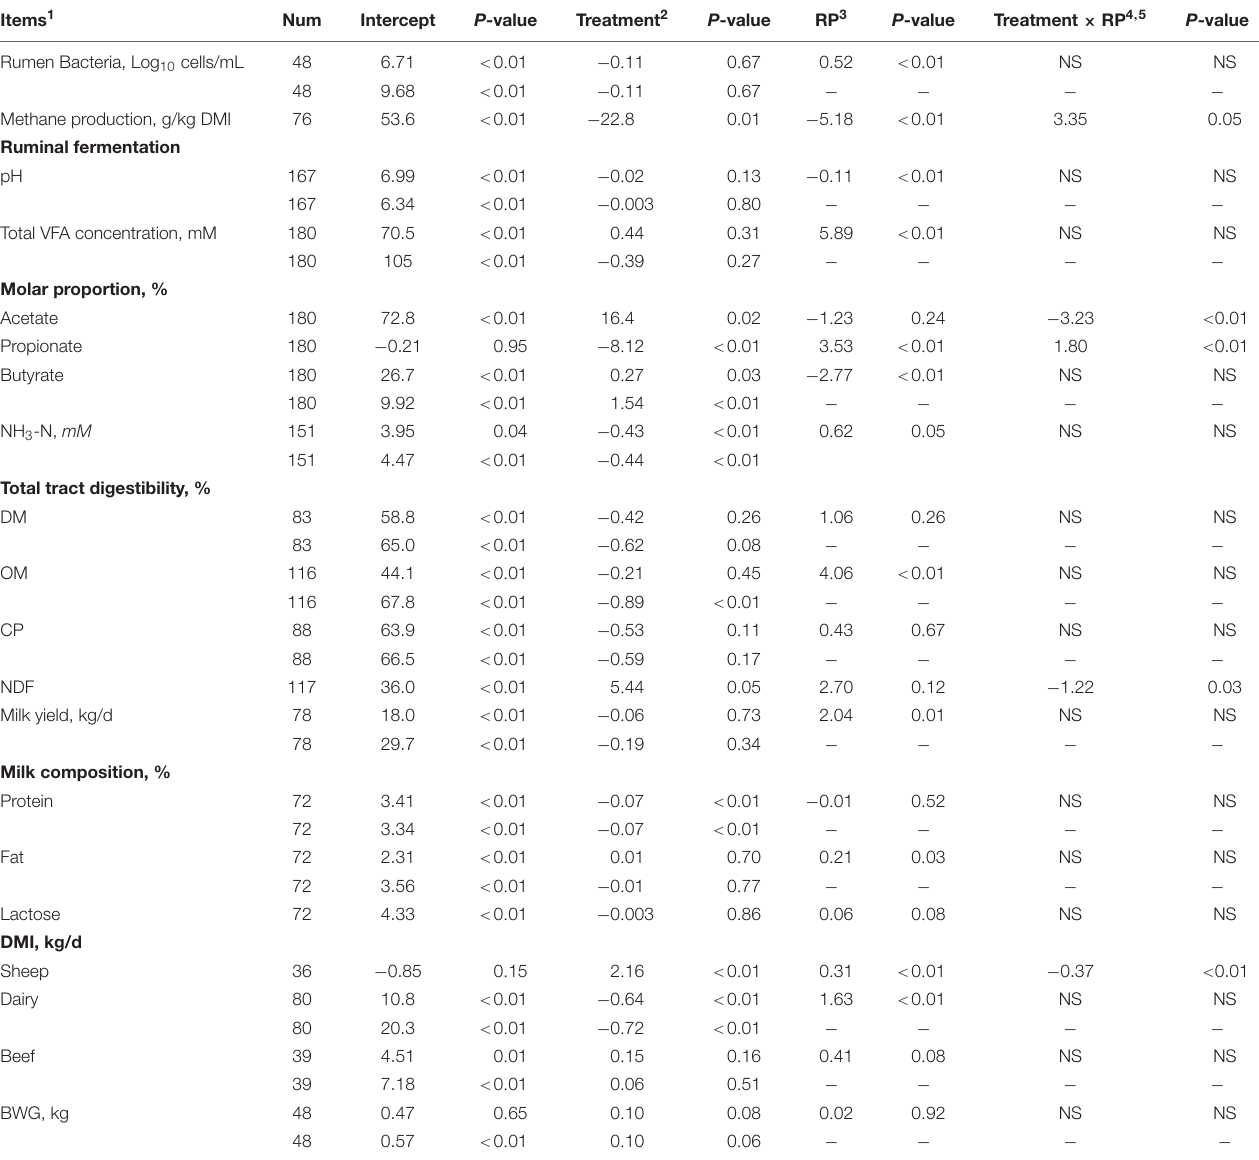
TABLE 7 | Effects of treatment (phytochemicals and lipid), ruminal protozoa (RP) and their interaction as predictors on the ruminal microorganisms, methane production, total tract digestibility, ruminal fermentation, and animal